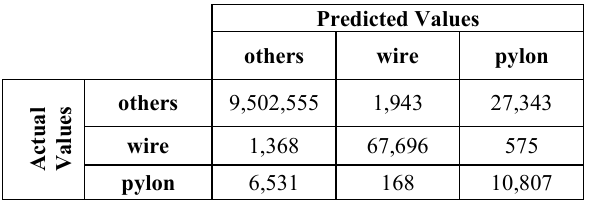
Table 2. Confusion matrix of the test set.